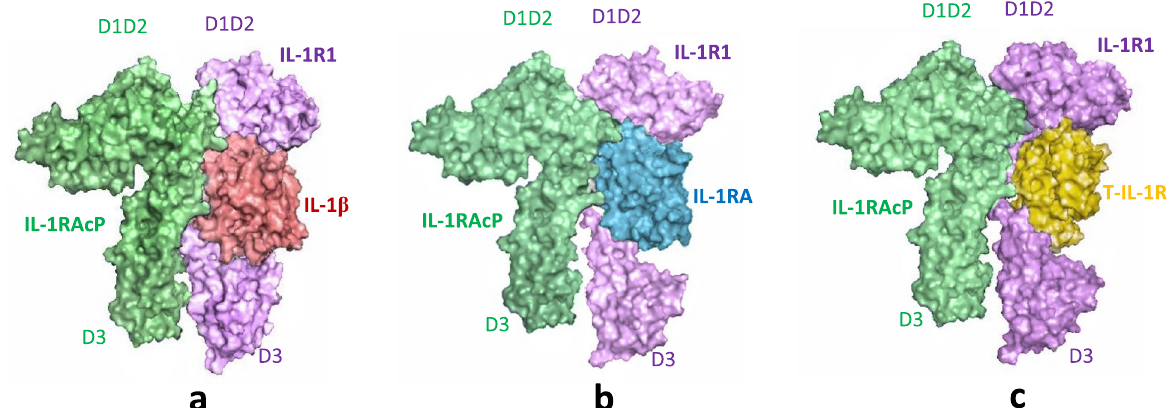
Figure 4. Comparison of natural and truncated IL-1 ligand in the complexes with IL-1R1/IL-1RAcP ( a ) surface representation of IL-1β/IL-1R1/IL-1RAcP structure. ( b ) Surface representation of IL-1RA/IL-1R1 in complex with IL-1RAcP. ( c ) Surface representation of T-IL-1RA in complex with T-IL-1RA.